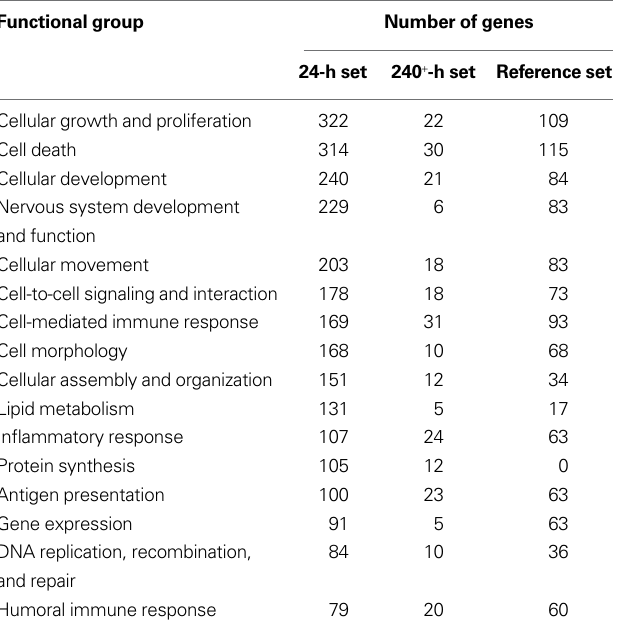
Table 3 | Distribution of genes from the gene sets among IPA’s functional groups. Only the most signifi cant biological functions are shown (based on the p -values from Fisher’s exact test).